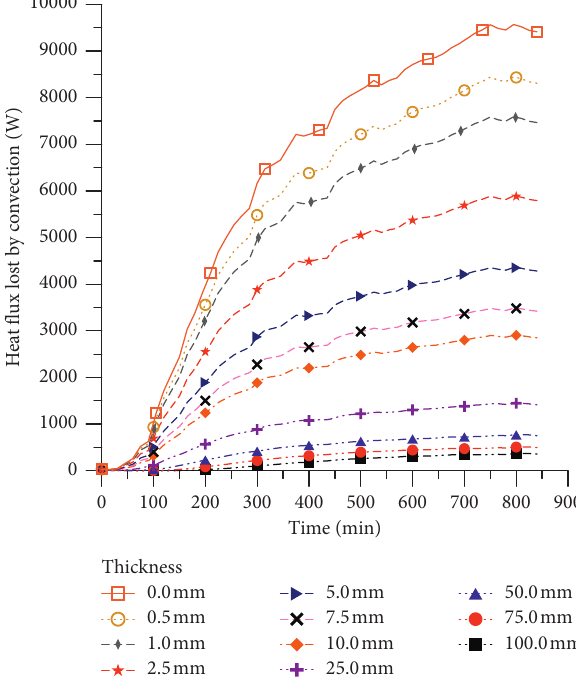
Figure 10: Heat flux lost by convection during the heating process for different ceramic fiber